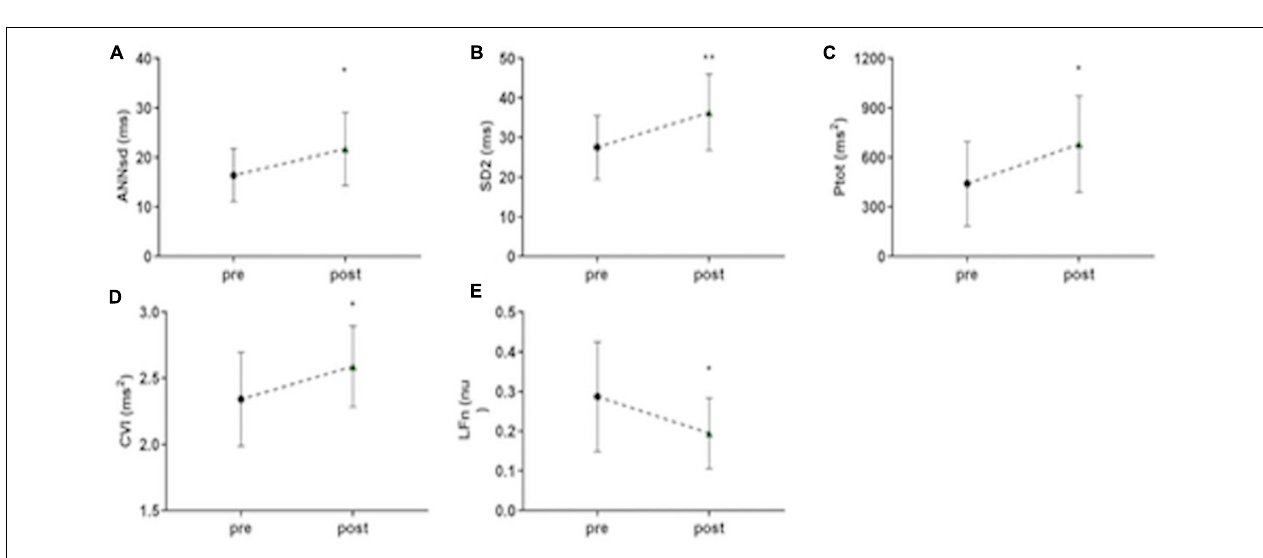
FIGURE 3 | The impact of musical stimulation on index-linked to ANS activity. (A) ANNsd (ms): standard deviation of the Average NN; (B) SD (ms): standard deviation perpendicular to the line of the identity of Poincairè Plot; short term variability, mainly controlled by parasympathetic tone; (C) Ptot (ms2): total power of fetal RR series, index of total HRV, mainly controlled by sympathetic tone; (D) CVI (ms2): Cardiac Vagal Index, the contribution of the parasympathetic nervous system to cardiac regulation; (E) LFn: low-frequency band (0.04–0.15 Hz) normalized for the total power; low-frequency band mainly controlled by sympathetic tone; pre: basal FANTE data collection; stimulus: stimulus FANTE data collection; post; post-stimulus FANTE data collection. *significant at the alpha level p < 0.05; **significant at the alpha level p < 0.01.